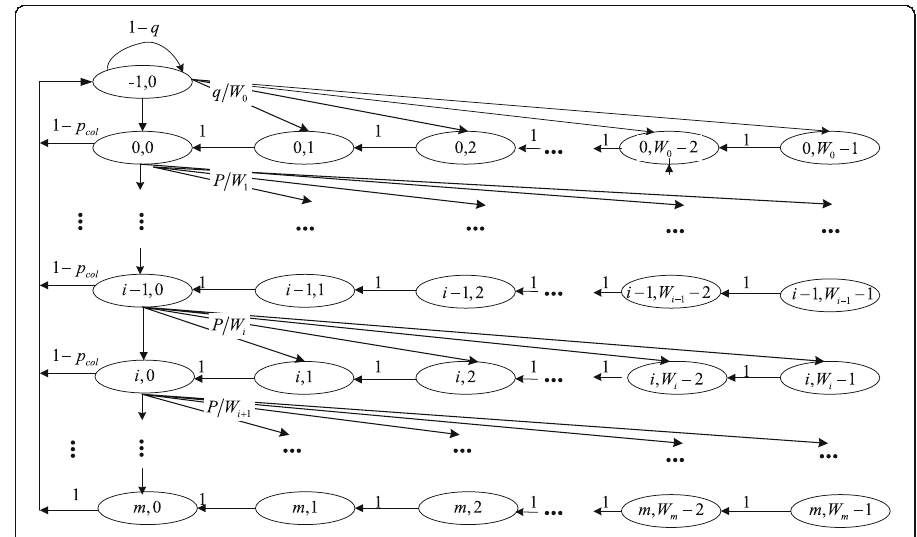
Fig. 5 2-dimensional Markov chain model for the proposed backoff